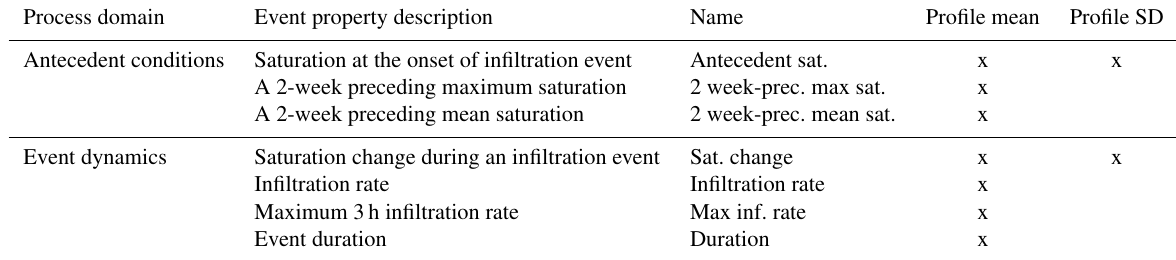
Table 2. List of event properties to describe infiltration events. To classify between triggering and nontriggering infiltration events, the nine event properties marked with “x” are used. Time series of the mean of water saturation and standard deviation (SD) of saturation were